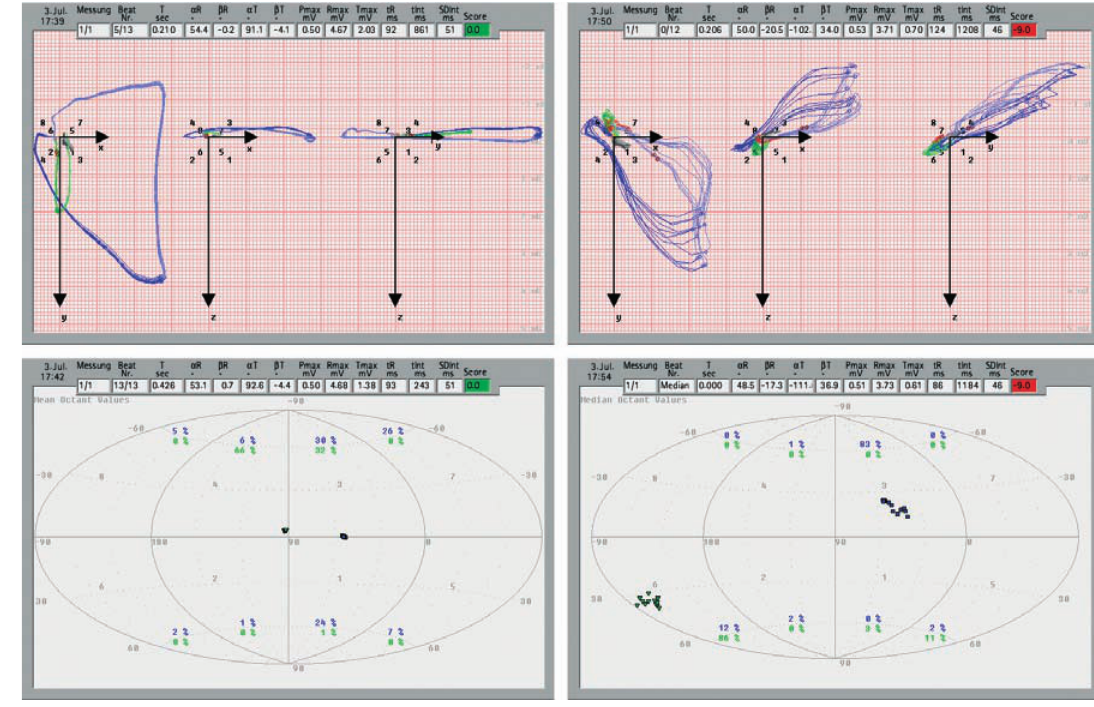
Figure 5 Vector loops and projections from a healthy person (left) and a patient with myocardial ischaemia (right). The images above show three orthogonal projections of the vector loops of several heart beats onto one plane: The loops on the left are the projection onto the OSP. The loops in the middle are the projection onto the sagittal plane perpendicular to the OSP, corresponding to the view onto the apex (four chamber projection in echocardiogra- phy). The loops on the right are the projection onto the frontal plane. Axes and projections of octant numbers are shown in black; P-loop in grey, R-loop in blue, RT-potentials in red, T-loop in green, TP-potentials are not shown. Note the pathological variability of the loops from heartbeat to heartbeat (“floating”) in the patient on the right side. The images below show the projection of the maximal vector of each R-loop (blue) and T-loop (green) onto the globe around the heart. Note the pathological orientation of the maximal T-vectors (basal, inferior, anterior) in the patient on the right side. Numbers of octants are indicated in grey. Percentages of R-loop (blue) and T-loop (green) potentials are shown for each